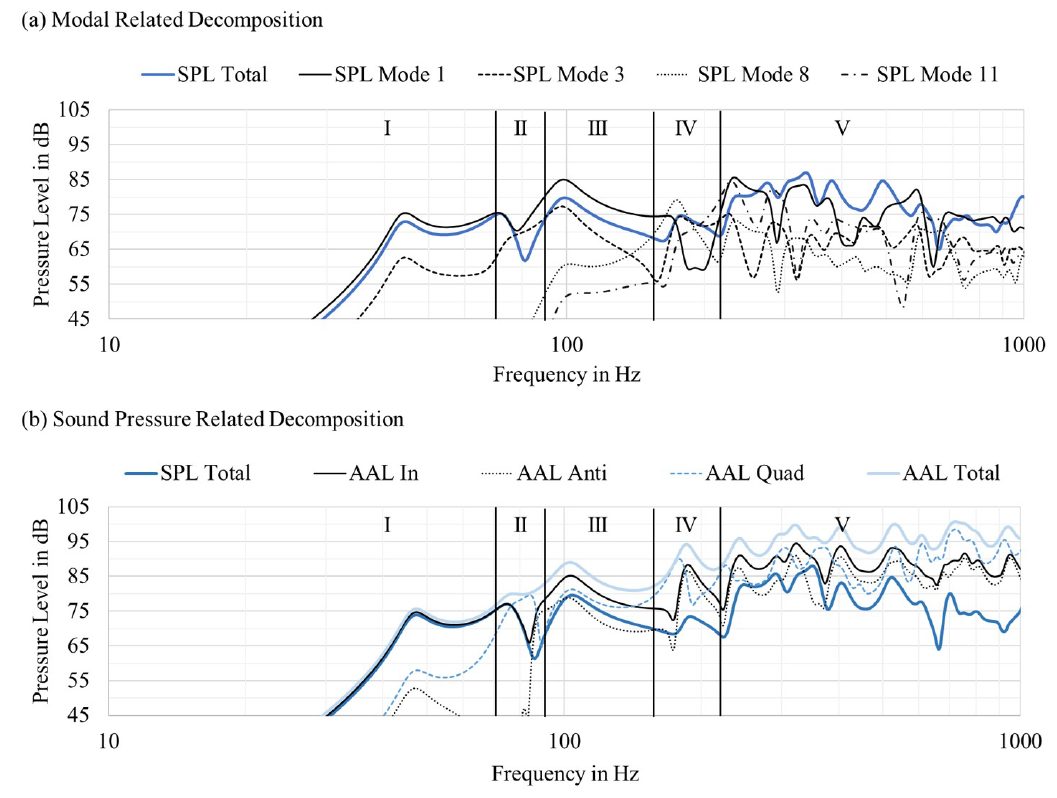
Figure 12. Simulated modal related and sound pressure related decomposition of the panel with an exciter (separation construction). The contribution of Modes 1–11 is extracted. All symmetrical eigenmodes are not excited due to the centered exciter